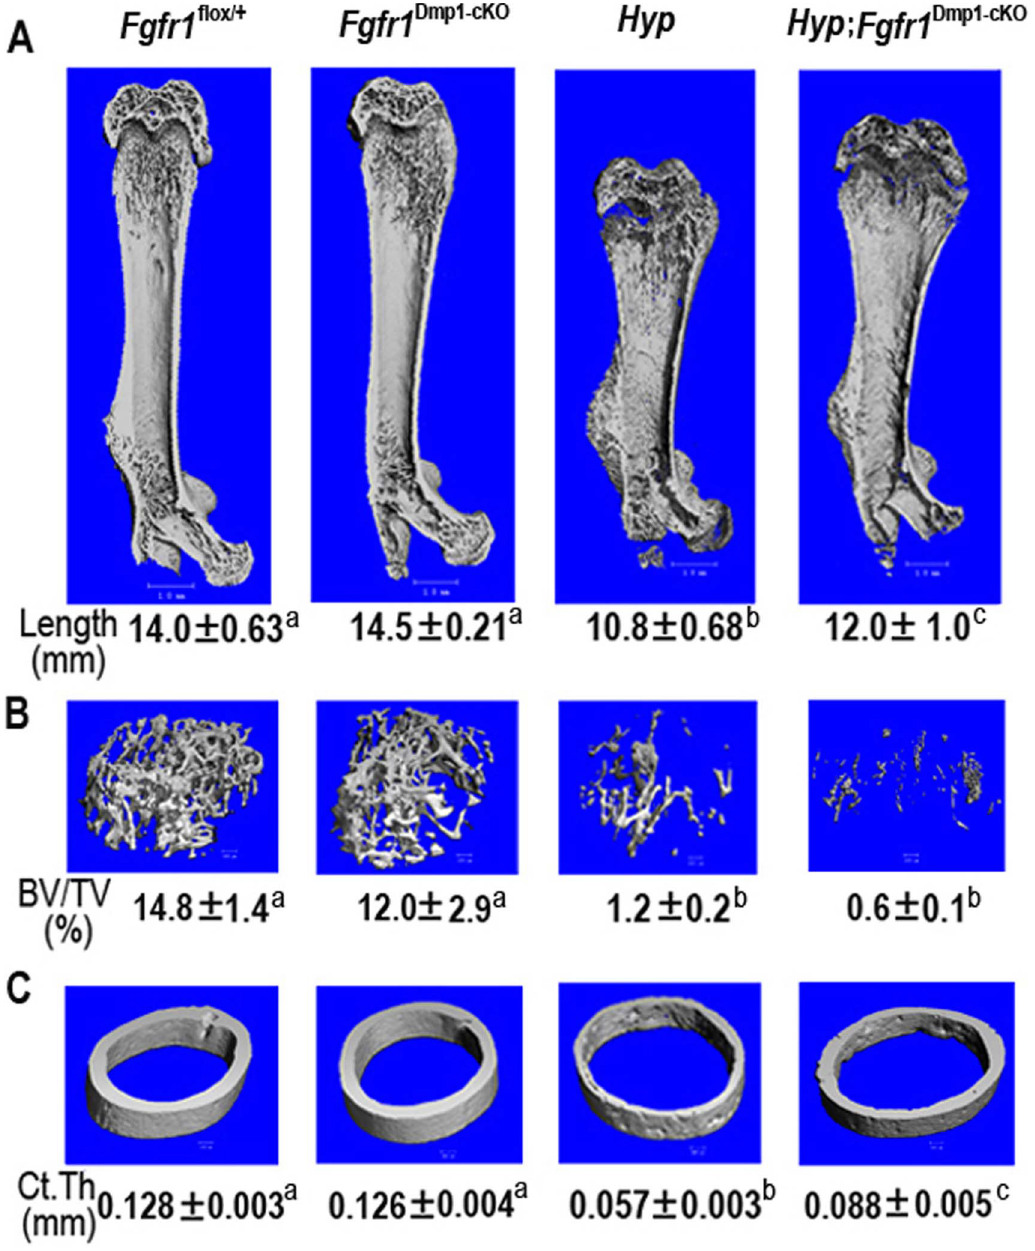
Figure 3. Effects of conditional deletion of Fgfr1 in Hyp osteocytes on bone structure in 6-week-old mice. Representative m CT 3D images of (A) whole femur segital section, (B) the distal femoral metaphyses, and (C) femoral midshaft diaphyses in four genotypes of mice. Compared with control mice, Fgfr1 Dmp1-cKO -null mice had normal bone structure. However, Hyp mice showed considerably shorter femur length, less trabecular bone volume, and thinner cortical thickness, compound Hyp ; Fgfr1 Dmp1-cKO -null mice displayed intermediate femur length and cortical thickness between control and Hyp mice, but no recovery was found in trabecular bone volume. Data are mean 6 S.D. from 5–6 individual mice. Values sharing the same superscript in A, B, and C are not significantly different at P , 0.05.